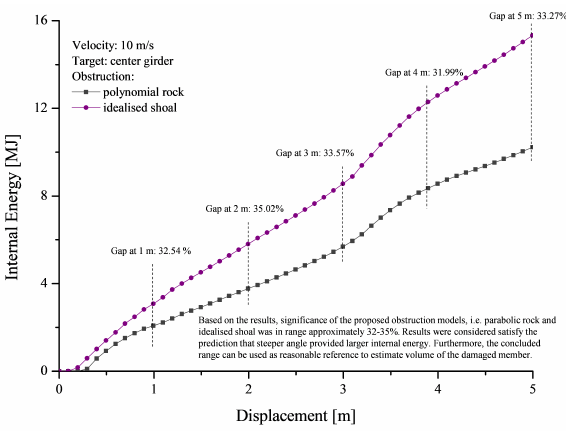
Figure 16: Internal energy of the double bottom accounting for geo- metrical variety of the obstruction.